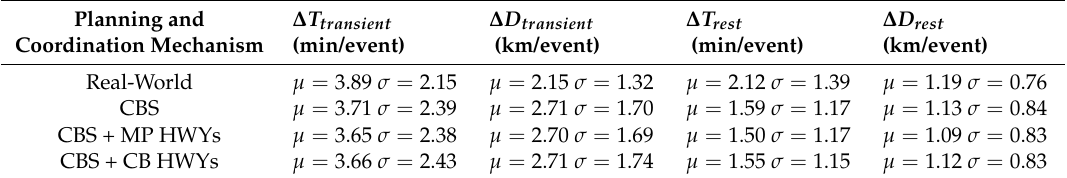
Table 5. MAS simulation average responses for the considered runway reconfiguration events of all